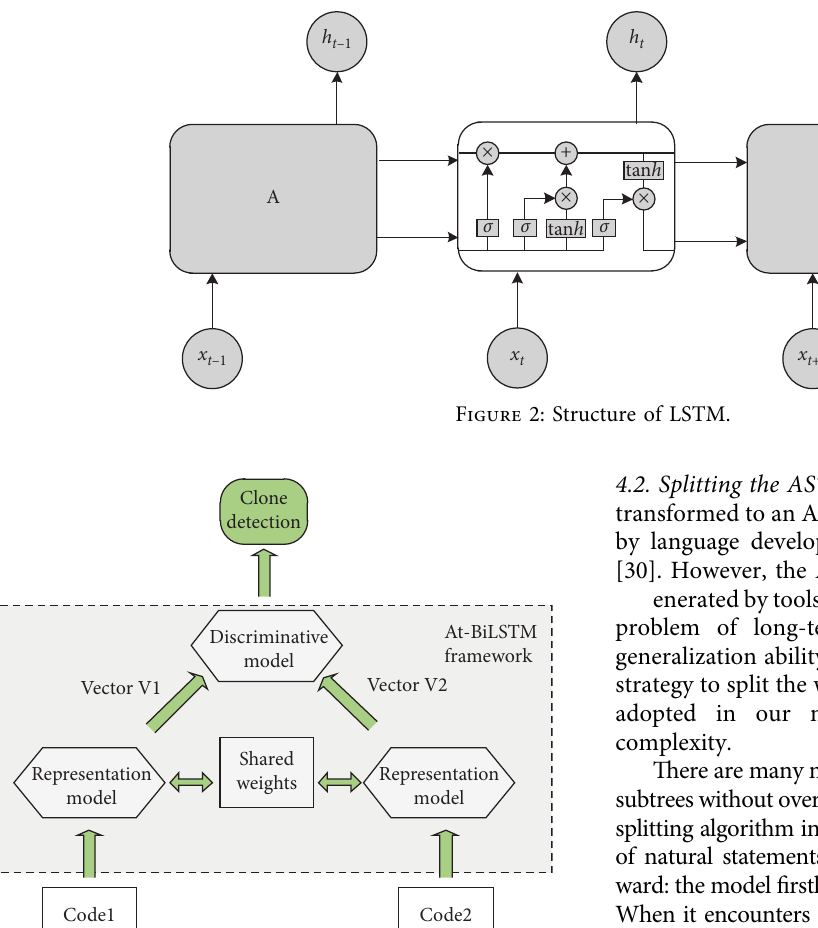
Figure 3: The architecture of At-BiLSTM.